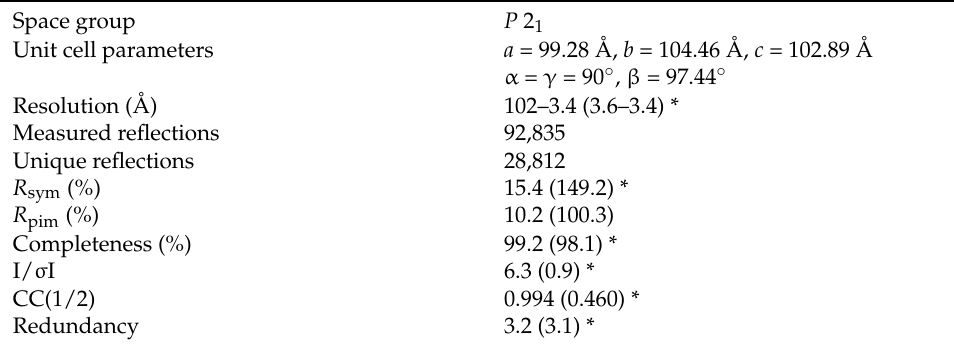
Table A2. X-ray data collection statistics.